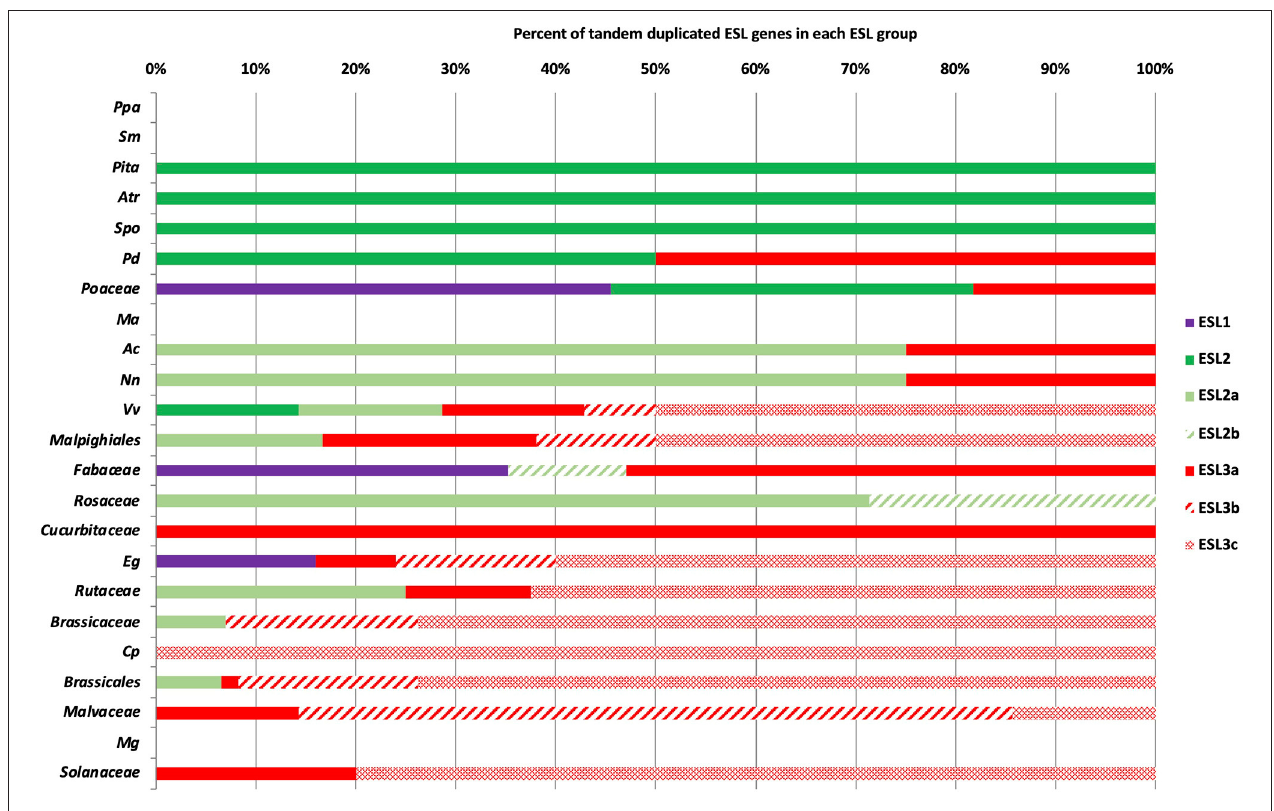
FIGURE 6 | The distribution of tandem duplicated ESL genes in the different ESL groups. % represents the percentage of tandem duplicated genes relative to the total number of ESL per species or botanical groups. Purple is for ESL1 , green for ESL2 , and red for ESL 3. For abbreviations see Supplementary Data 1 .